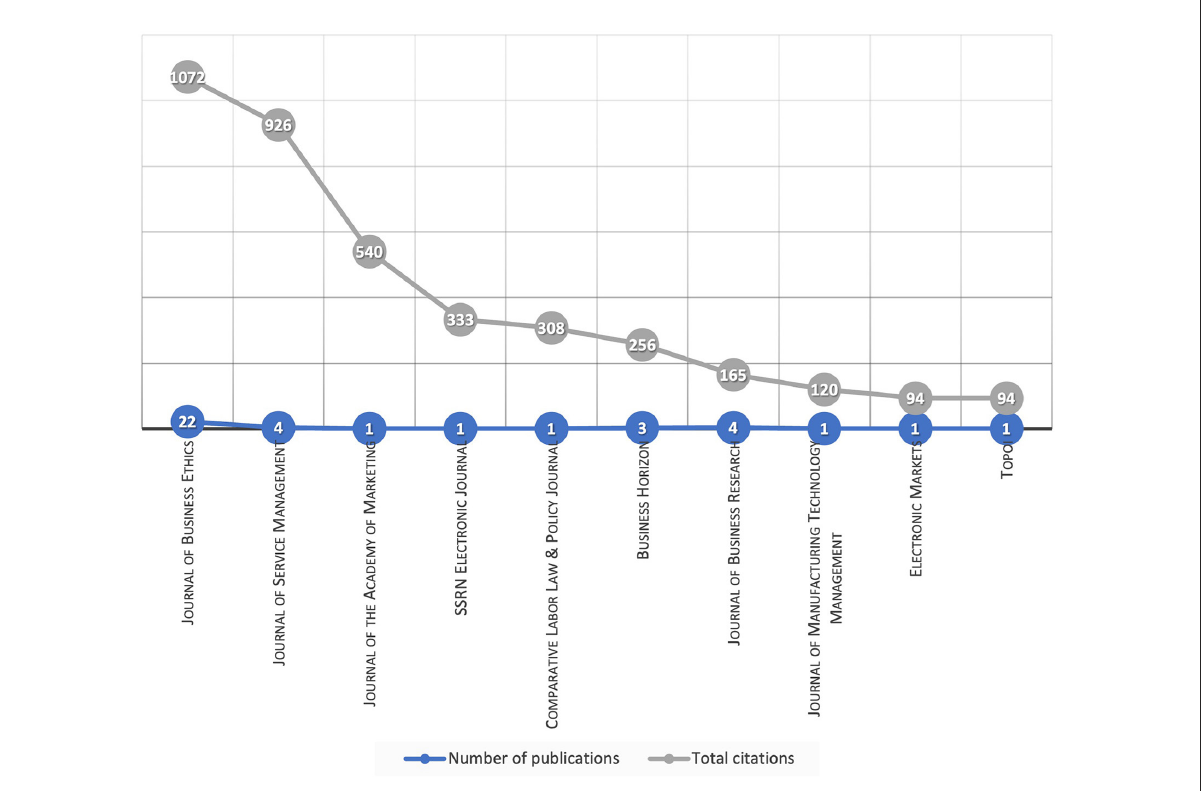
FIGURE1 Influence and productivity of academic